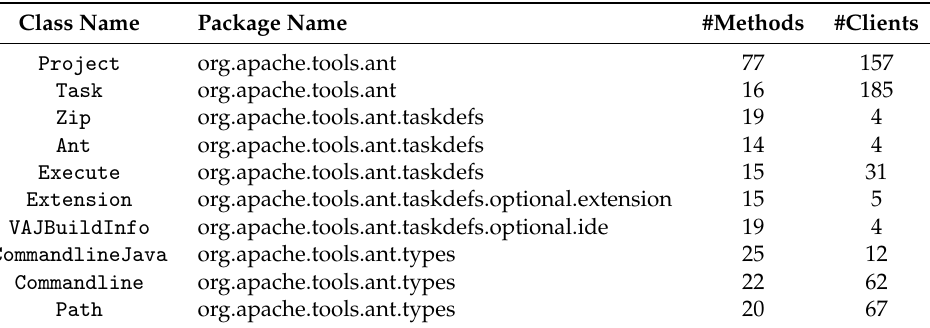
Table 3. The classes selected from Ant